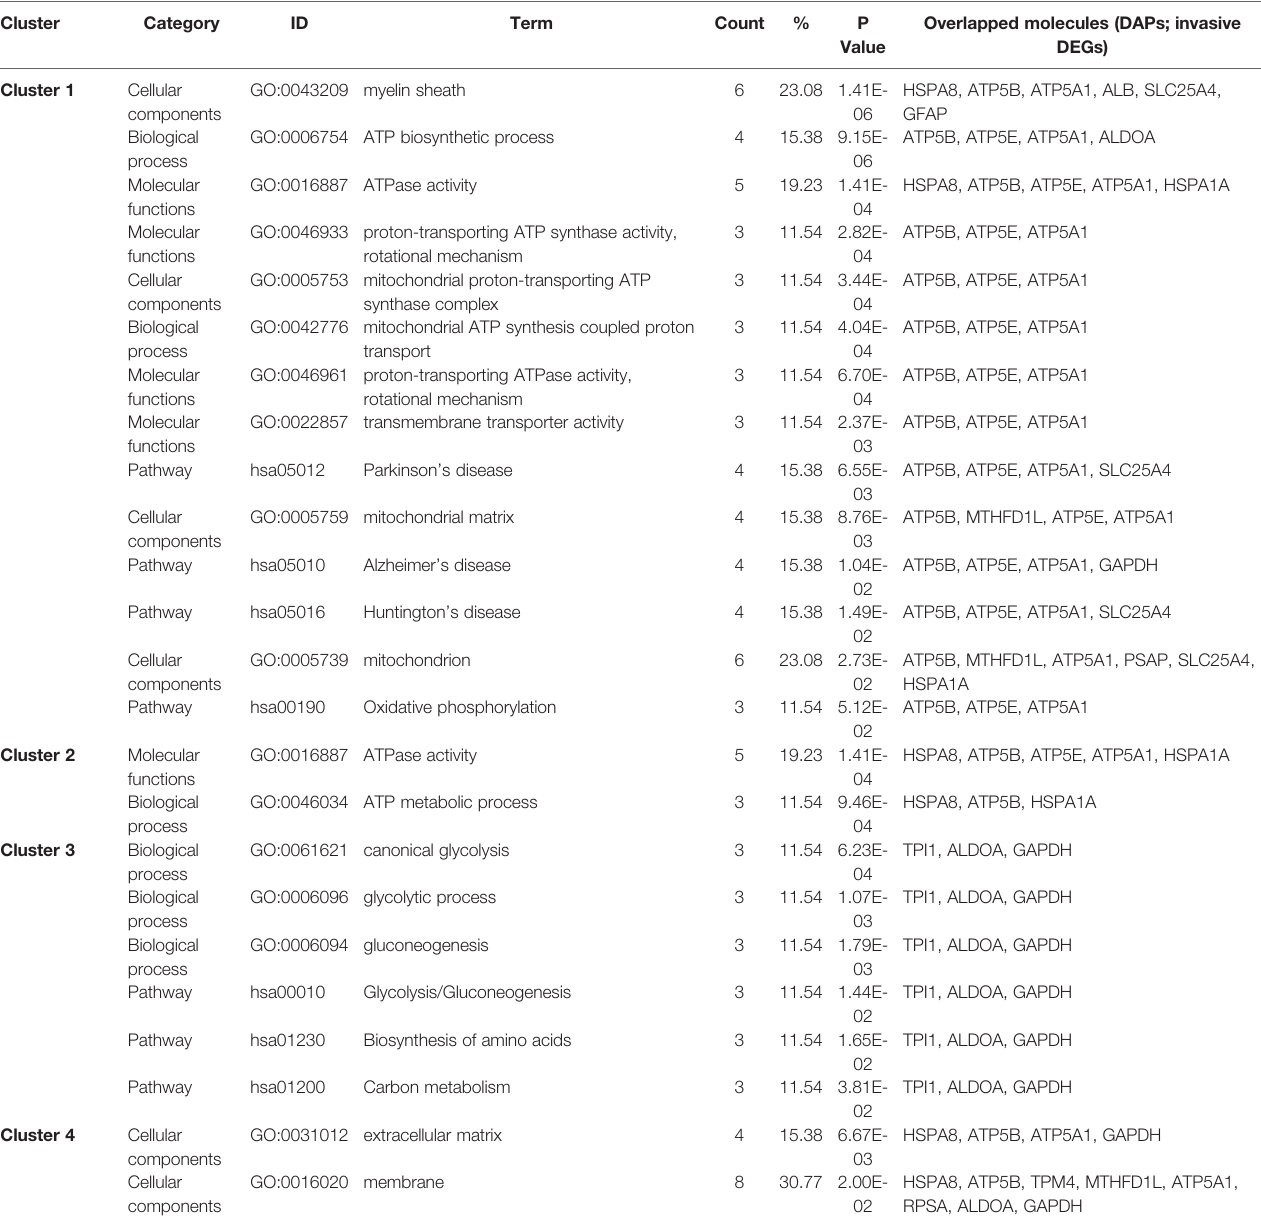
TABLE 3 | Cluster analysis of KEGG pathways, MFs, CCs, and BPs enriched with overlapped molecules (DAPs; invasive DEGs) in